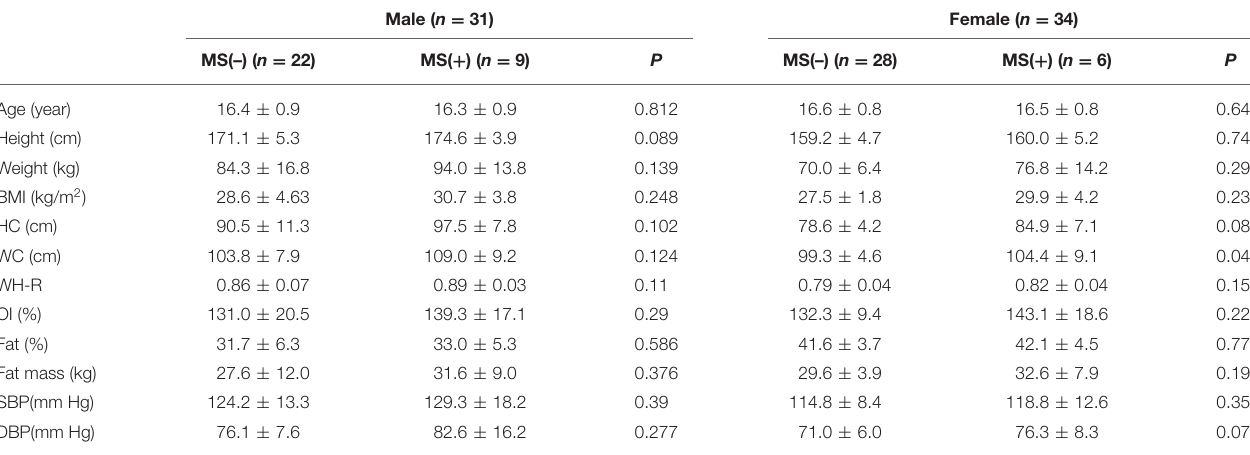
TABLE 2 | Comparison of anthropometric data in obese adolescents.